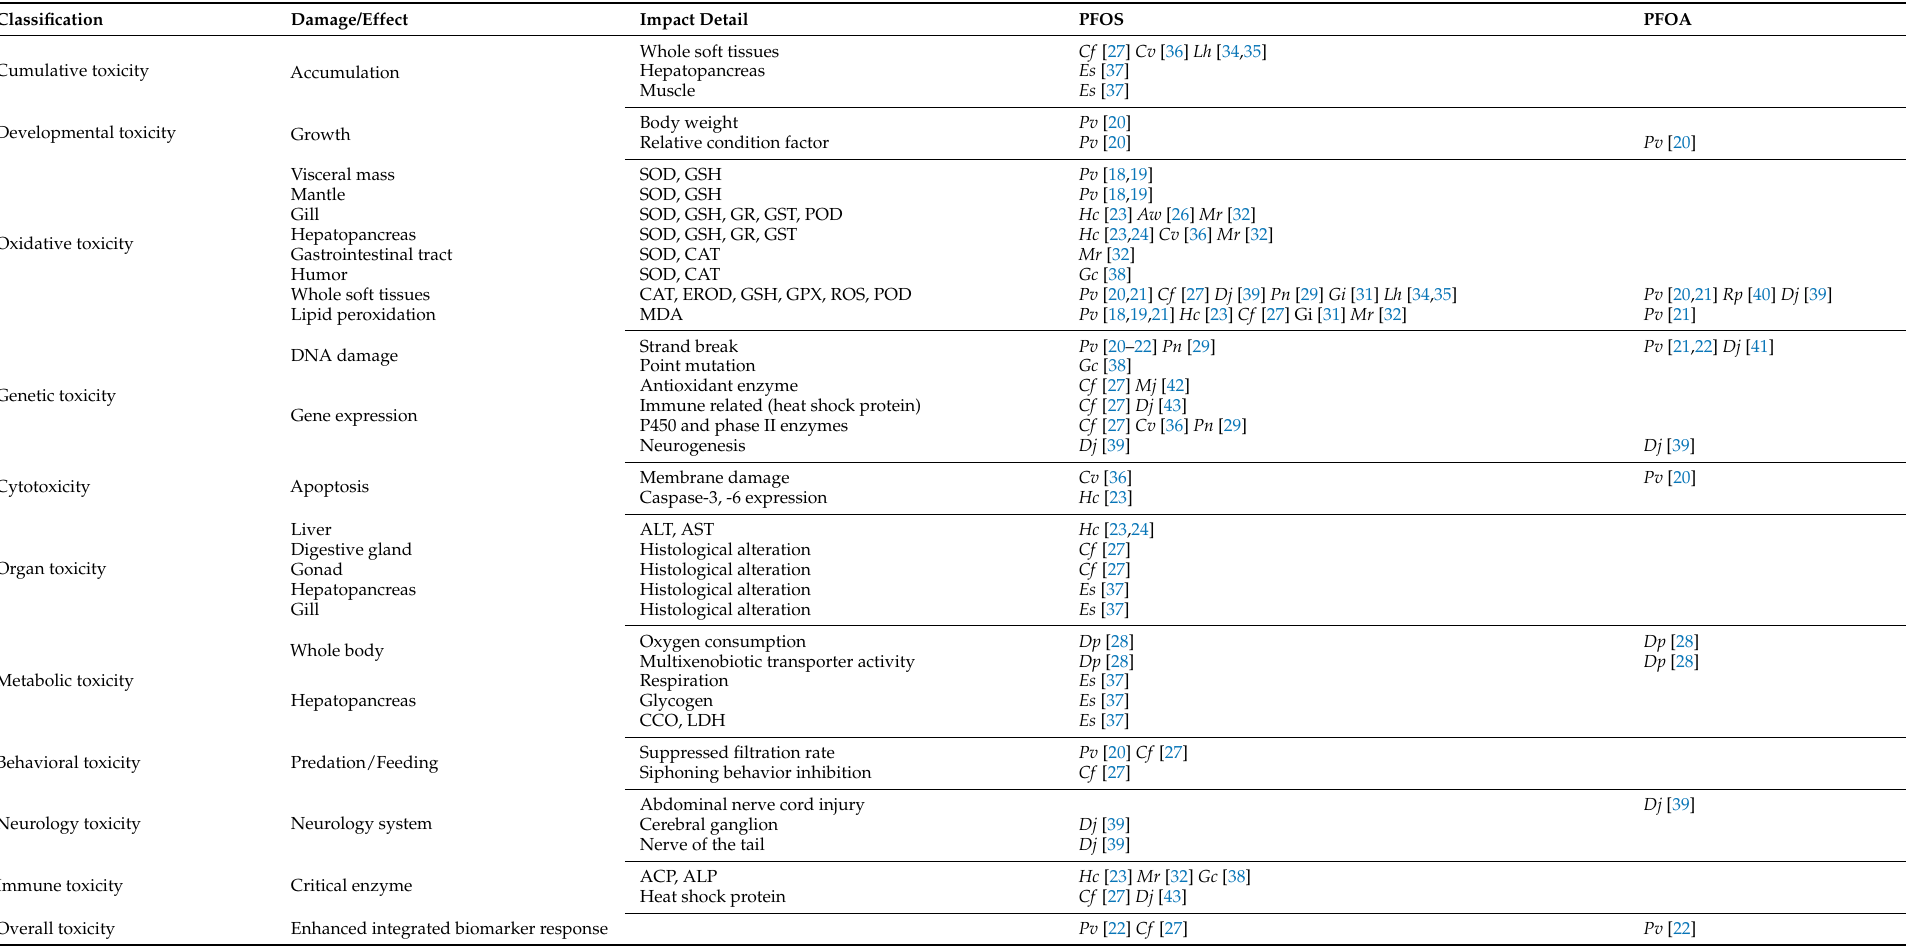
Table 2. Toxicity effects of commonly detected single PFASs on aquatic